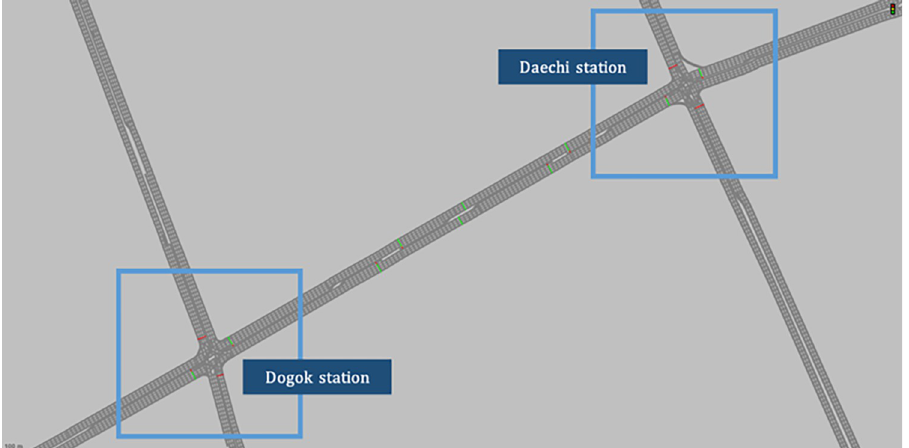
Fig 8. A network with two intersections built in